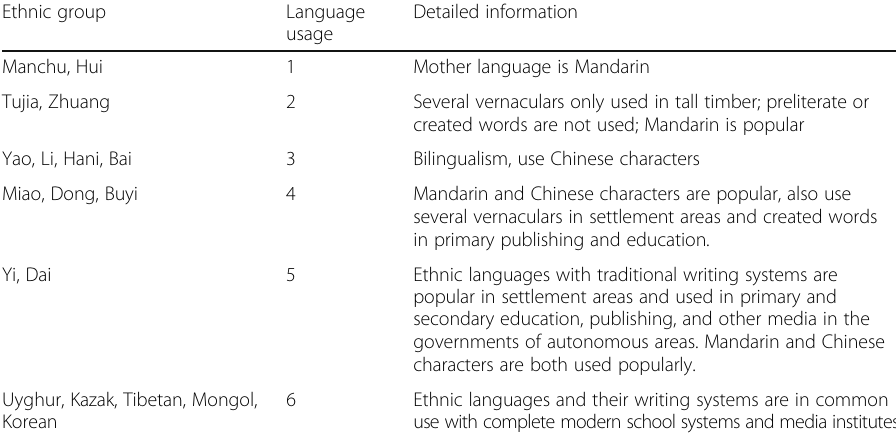
Table 5 Conditions of language use of 18 ethnic groups Ethnic group Language